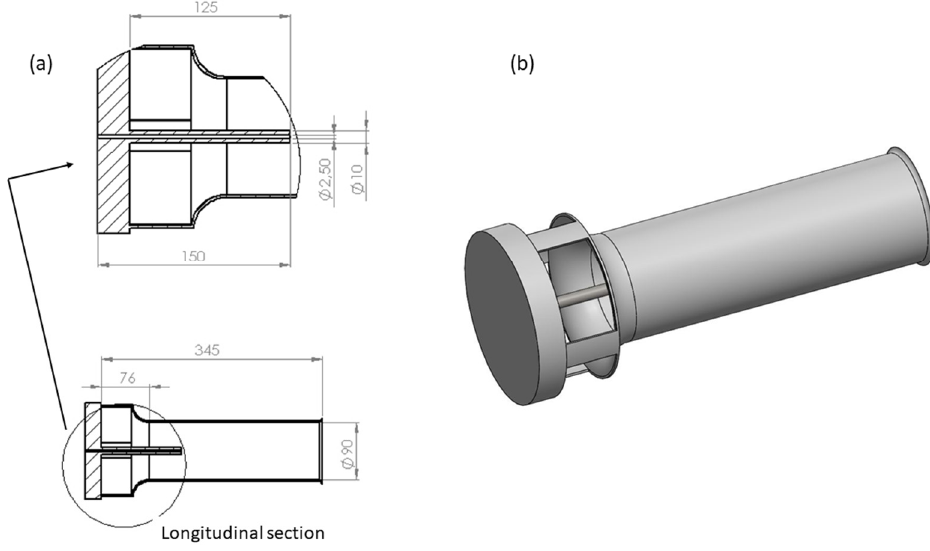
Figure 2. Geometry of the Venturi agitation nozzles. ( a ) Longitudinal section; ( b ) Three-dimensional (3D) view. Dimensions in millimetres.